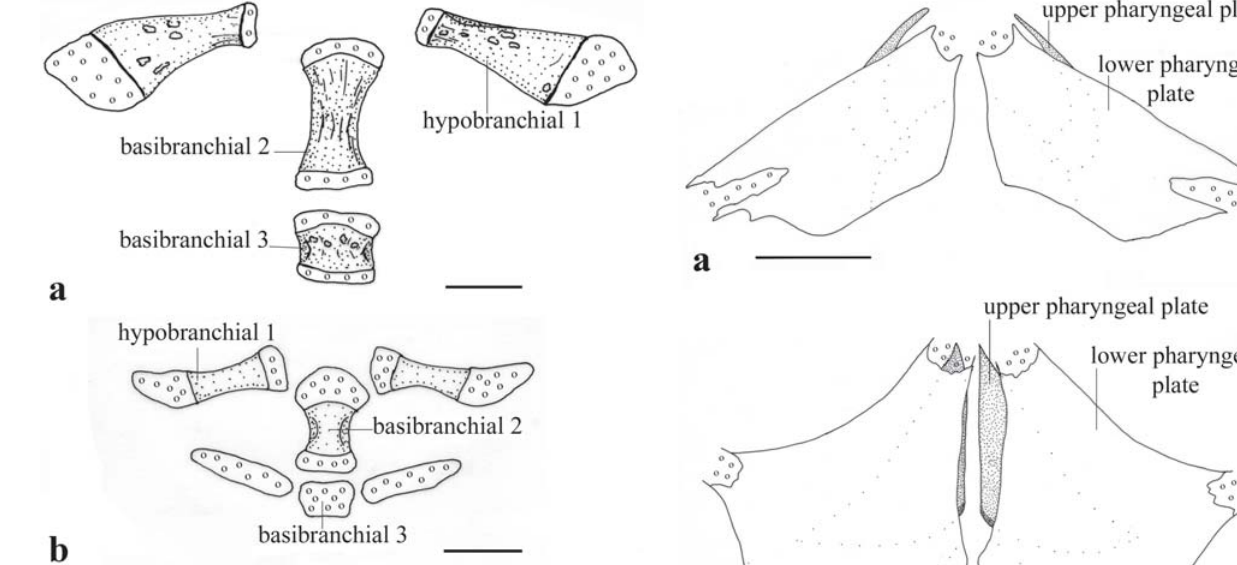
Fig. 22. Dorsal view of hypobranchial 1 and basibranchials 2 and 3 of Lamontichthys avacanoeiro (MZUSP 61974, 113.7 mm SL, paratype) (a), and Neoplecostomus ribeirensis (MZUSP 100920, 45.3 mm SL) (b). Scale bar = 0.5 mm.